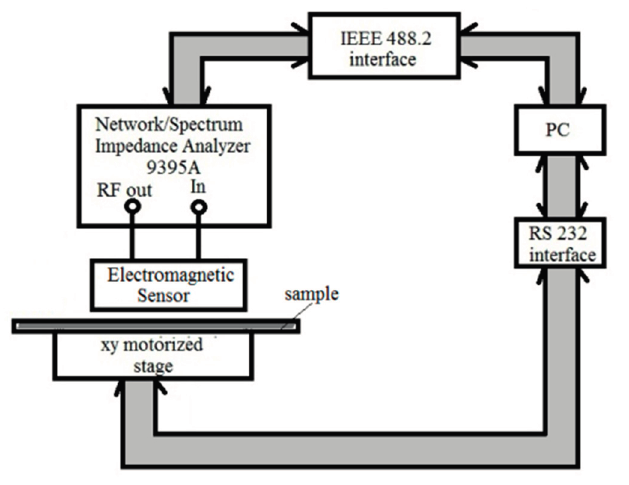
Figure 4. Experimental